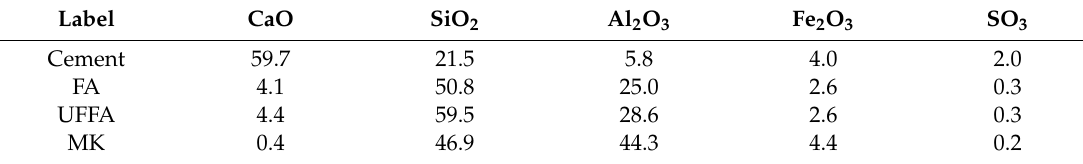
Figure 2. Particle size distribution of SCMs in this study. Table 2. Chemical composition of cement and SCMs